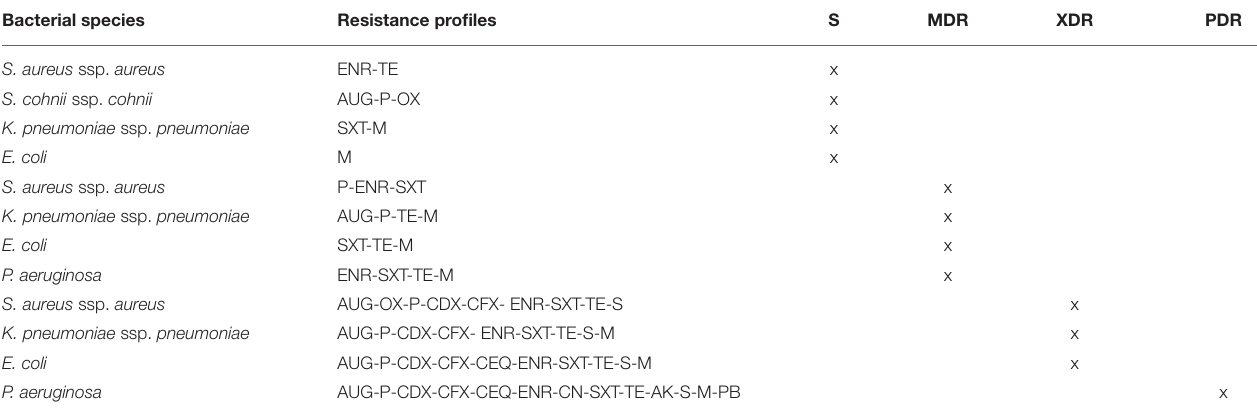
TABLE 2 | Antimicrobial resistance profiles of microorganisms selected and identified by MALDI-TOF MS from canine wounds. Bacterial species